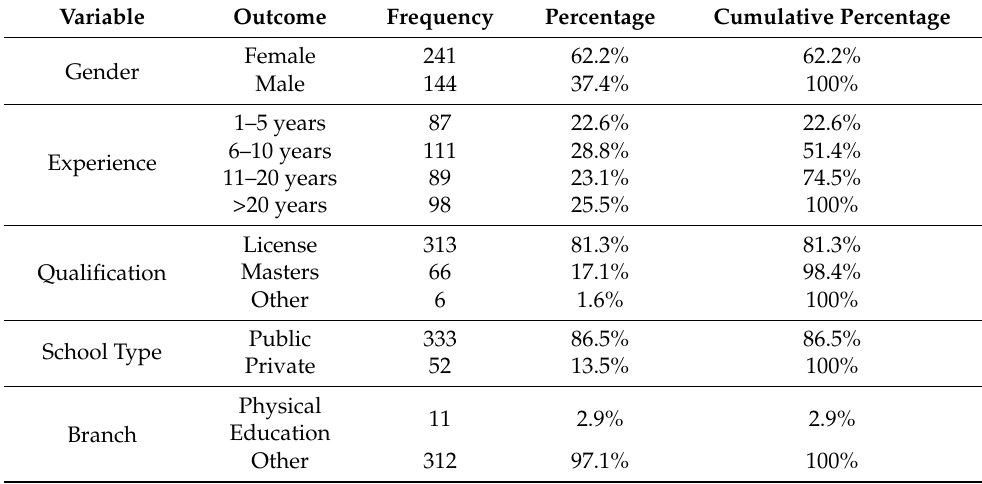
Table 1. Demographic characteristics of elementary schoolteachers, Istanbul, Turkey,